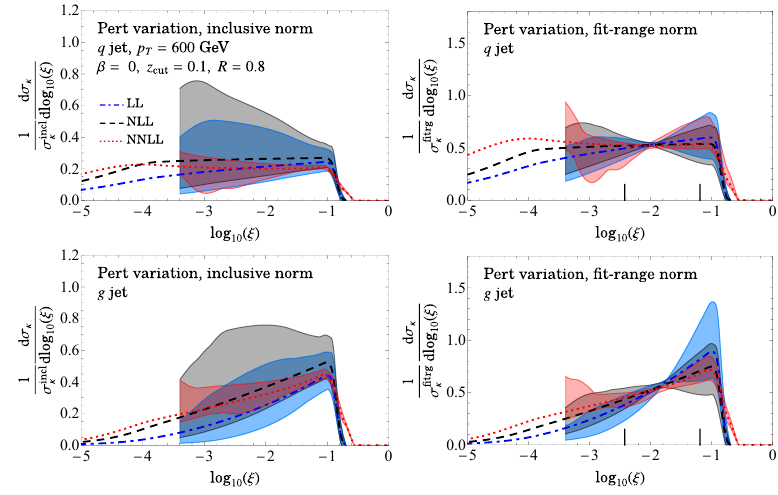
Figure 18 . An envelope of the profile variations for quark and gluon jets respectively, at LL, NLL and